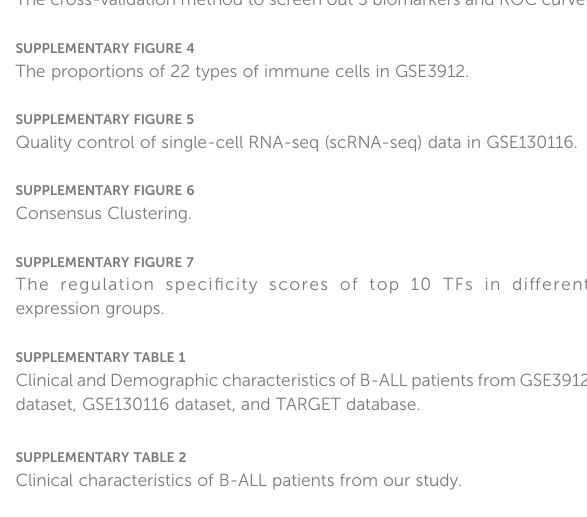
SUPPLEMENTARY TABLE 2 Clinical characteristics of B-ALL patients from our study.